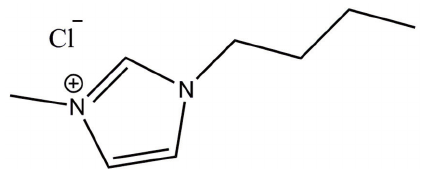
Figure 1: 1-Butyl-3-methylimidazolium chloride ionic liquid